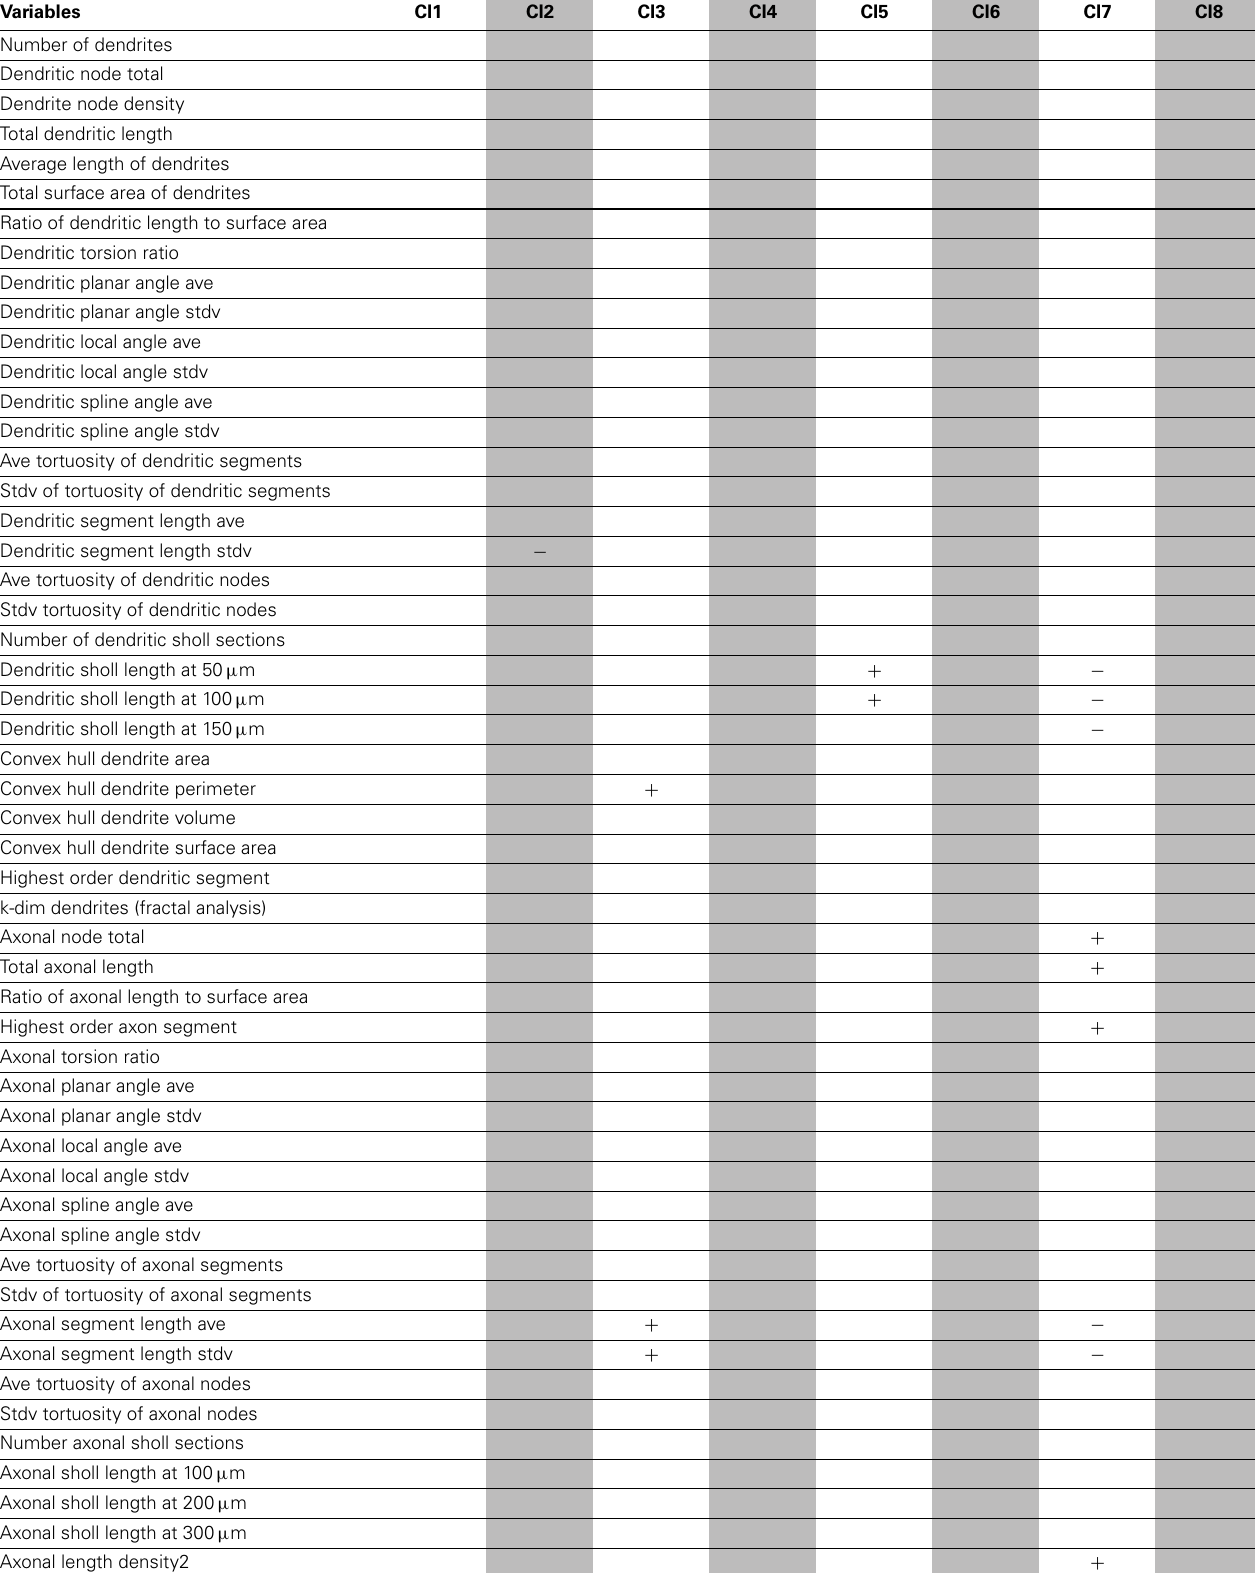
Table 4 | Significant variables for each cluster of the combined Morphology + Physiology database.